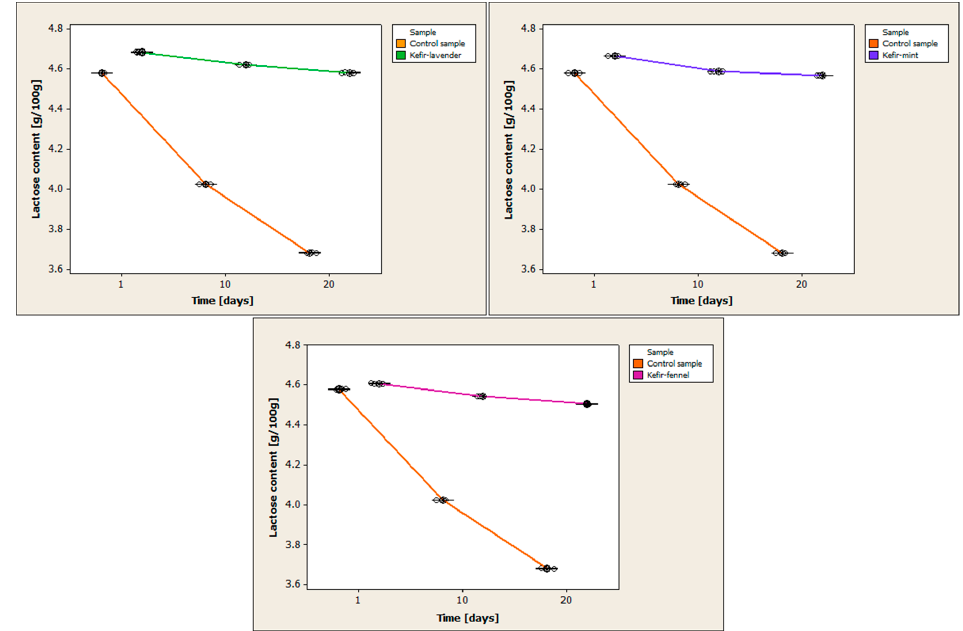
Figure 3. Comparative variation of lactose content determined by the enzymatic method in kefir samples with encapsulated volatile oils and the control sample.